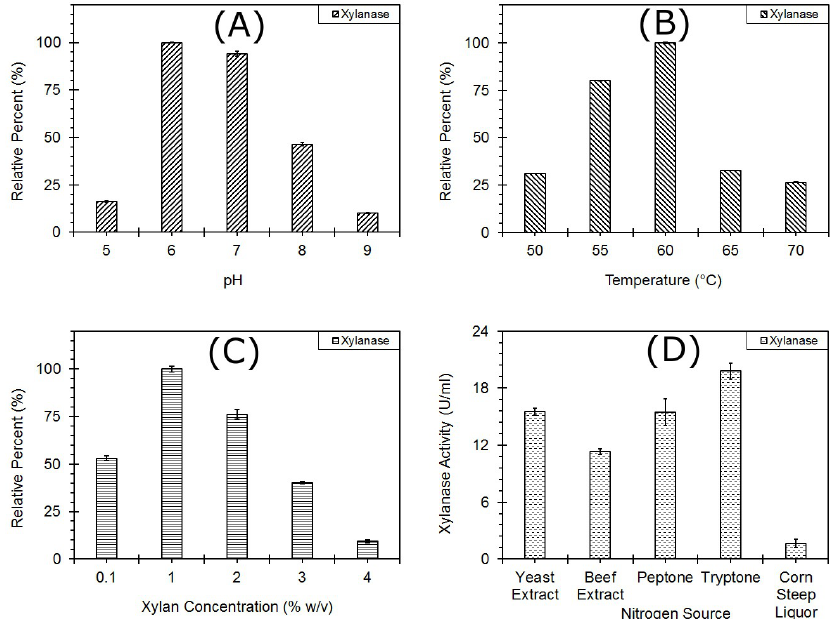
Figure 3. ( A ) The effect of growth pH profile on the xylanase activity of Geobacillus sp. strain DUSELR13. The maximum enzyme activity (8.54 U/mL) is taken as 100%; ( B ) the effect of growth temperature profile on the xylanase activity of Geobacillus sp. strain DUSELR13. The maximum enzyme activity (9.23 U/mL) is taken as 100%; ( C ) the effect of xylan concentration on the xylanase activity of Geobacillus sp. strain DUSELR13. The maximum enzyme activity (17.4 U/mL) is taken as 100%; and ( D ) the effect of nitrogen source on the xylanase activity of Geobacillus sp. strain DUSELR13. Values shown were the mean of triplicate experiments and the error bars represent ± SD of the means with n = 3.